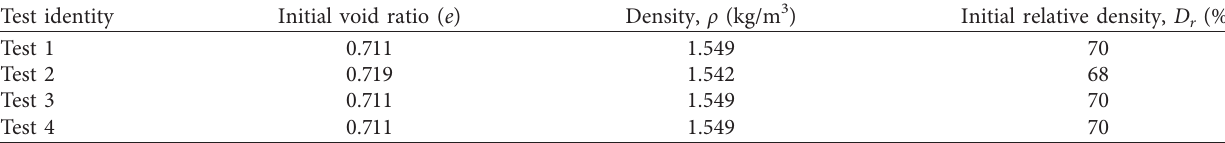
Table 3: Parameters of sand layer materials after model preparation in the four centrifuge model tests.